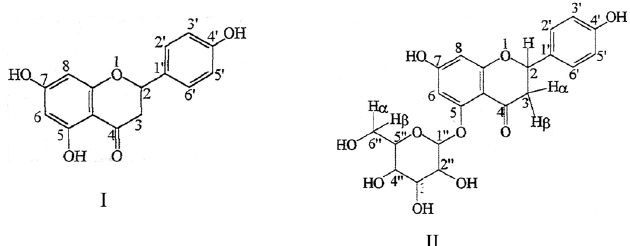
FIGURE 1 - Chemical structure of naringenin (I) and 5- b -D- glycosyl-naringenin